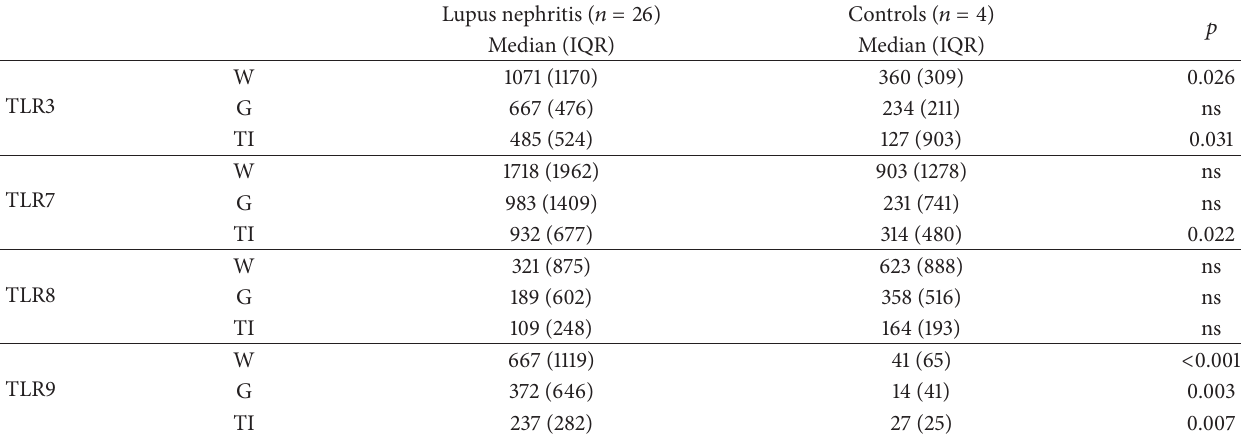
Table 2: TLR3, TLR7, TLR8, and TLR9 expressions in kidney section of lupus nephritis patients and healthy controls.